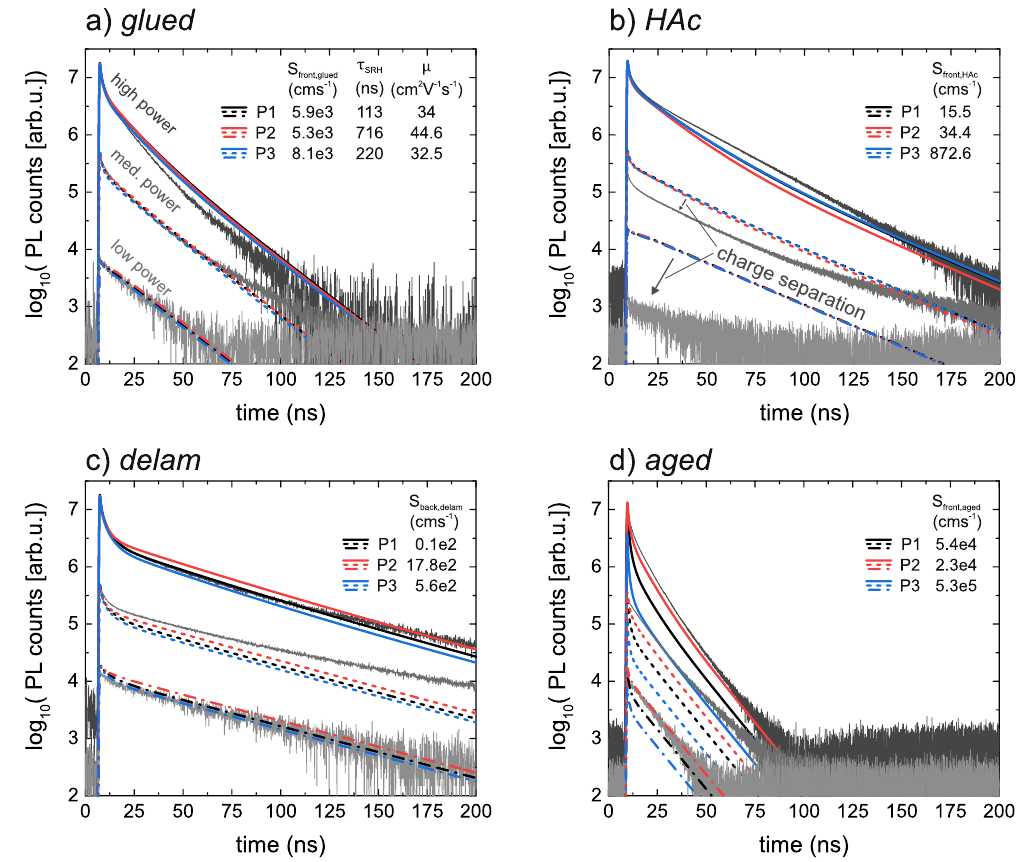
Figure 7. Simulated (colored) and measured (black) transients based on three parameter sets (P1, P2 and P3) deduced by the mathematical considerations in section 4.1. See also Fig. 4 for details of P1, P2 and